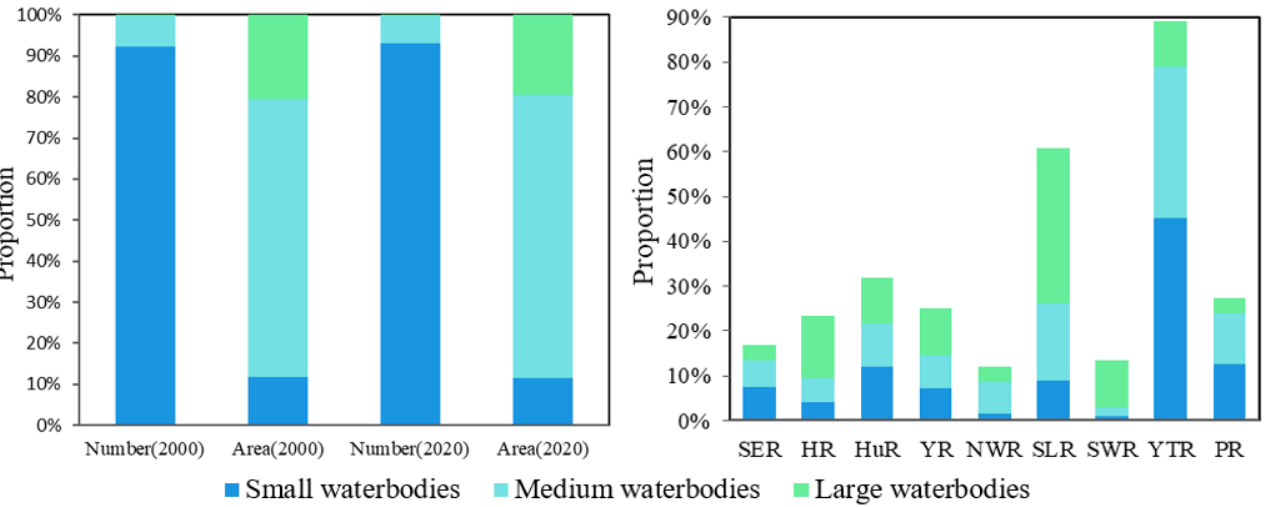
Figure 11. The proportion of artificial water body types in China in 2000 and 2020 and the proportion of artificial water body types in each basin in China in 2020.